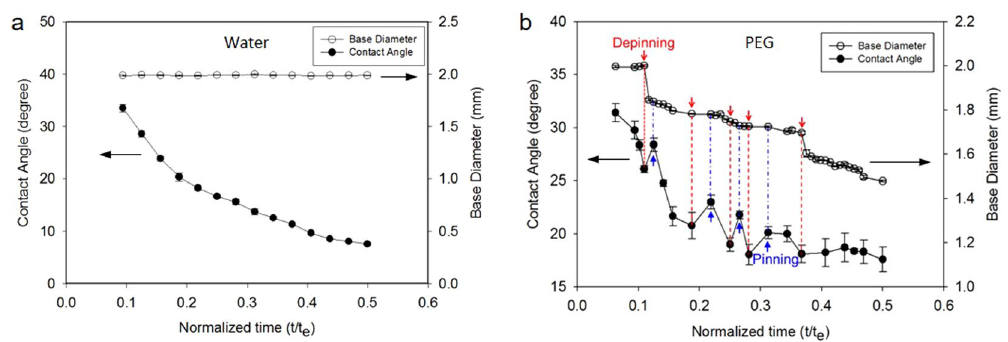
Figure 4. Variation of contact angle during pinning and receding. ( a ) water and ( b )